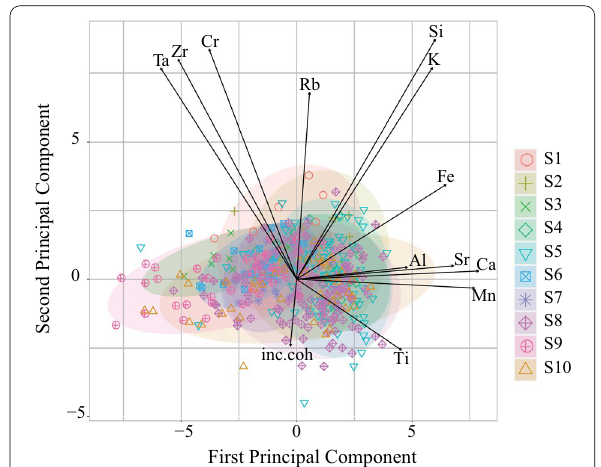
Fig. 8 Principal component analysis results for XRF core scanning results in core H02